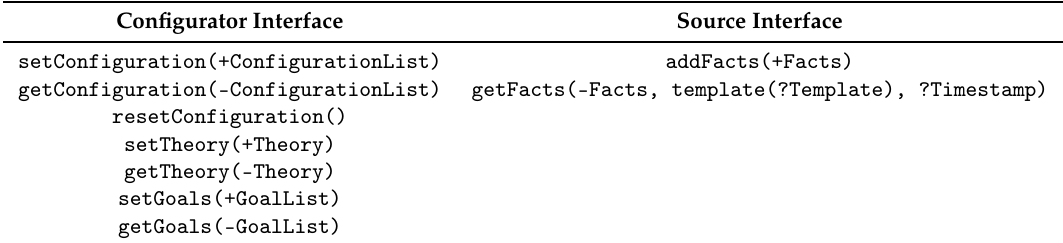
Table 1. LPaaS configurator interface (left) and LPaaS source interface